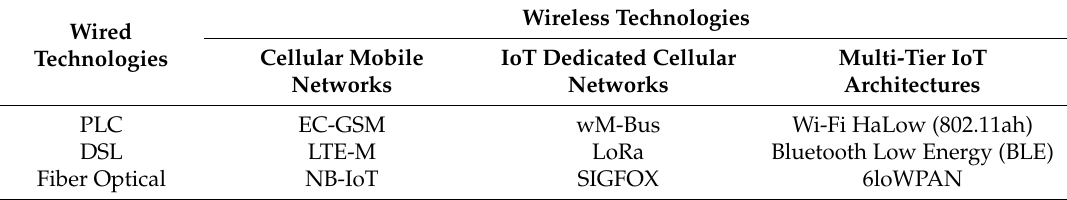
Table 3. Classification of enabling transmission technologies for smart metering.